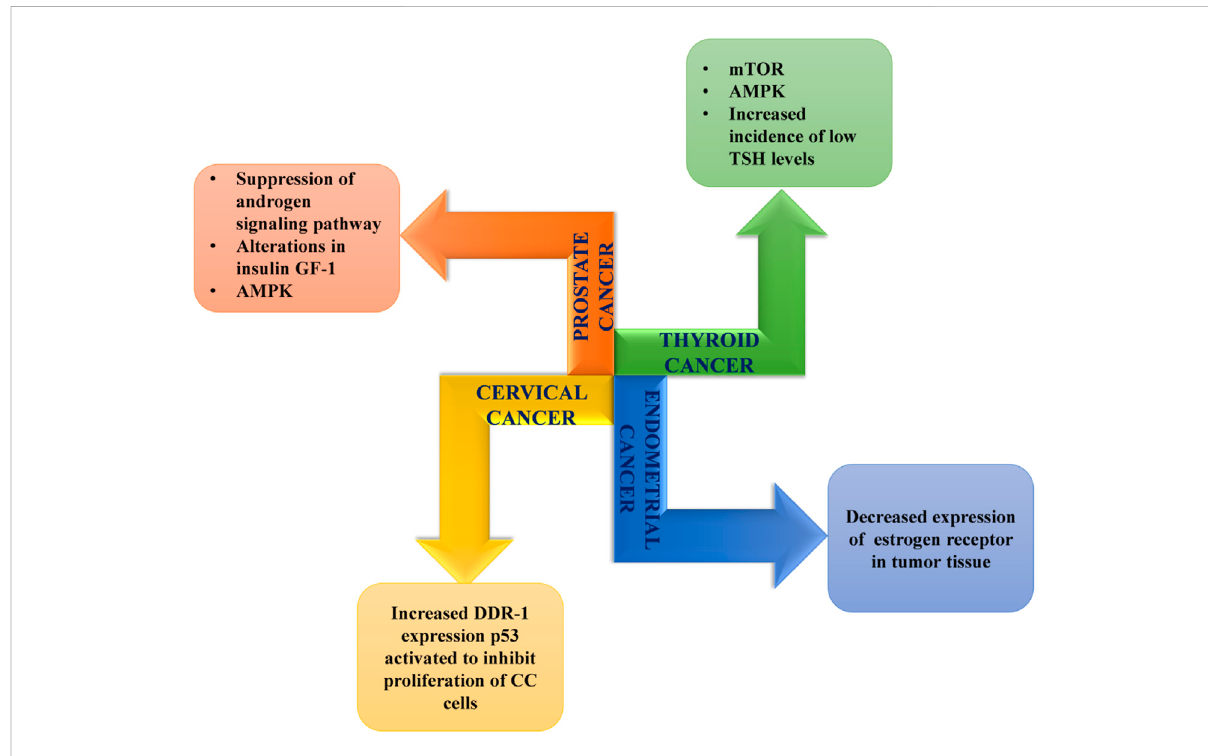
FIGURE 5 Mechanisms associated with anticancer effects of